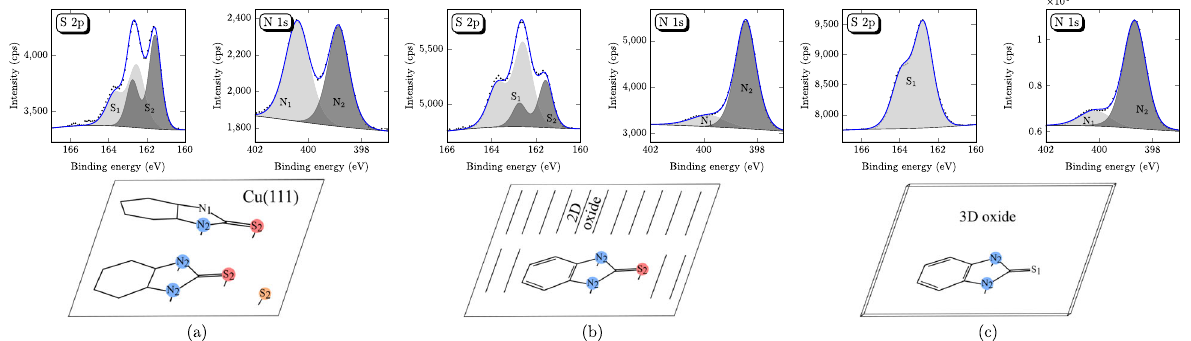
Fig. 7 Schema of 2-MBI adsorption on copper surfaces and the corresponding S 2p and N 1s spectra. a Metallic; b oxidized (2D oxide); c oxidized (3D oxide).